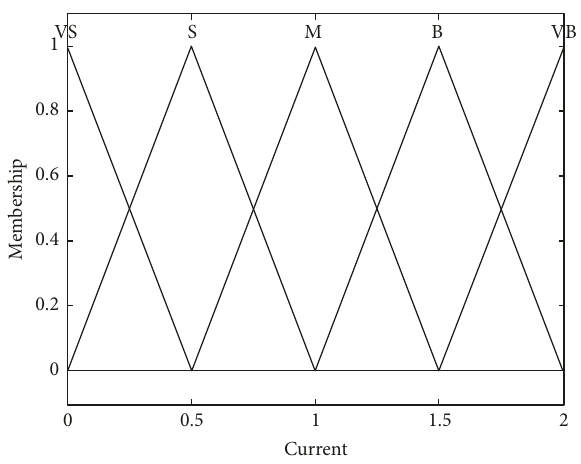
Figure 10: Current membership function